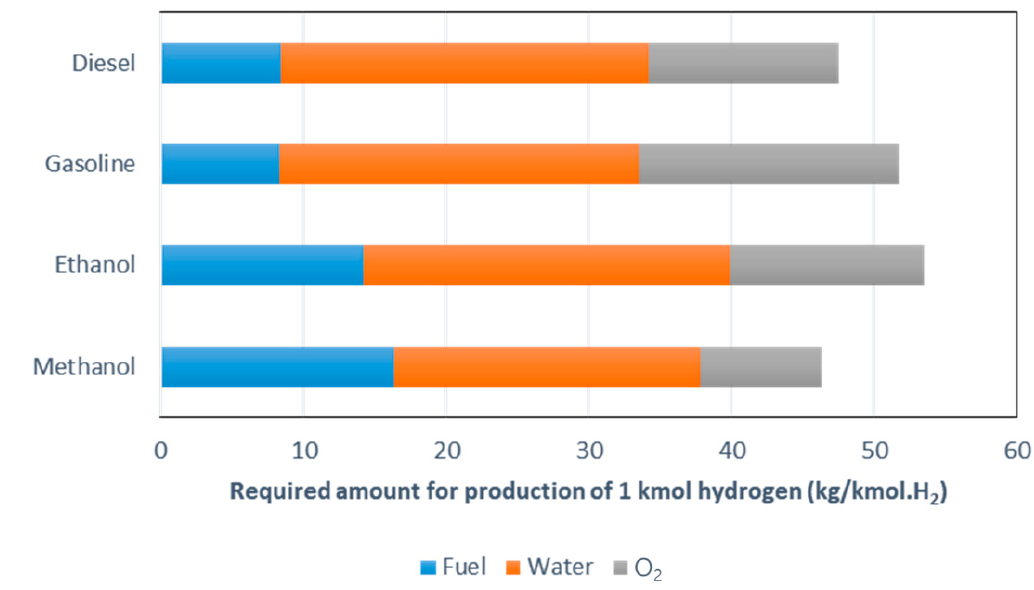
Figure 3. Reactants consumption per produced H 2 of 1kmol for diesel, gasoline, ethanol, and methanol.